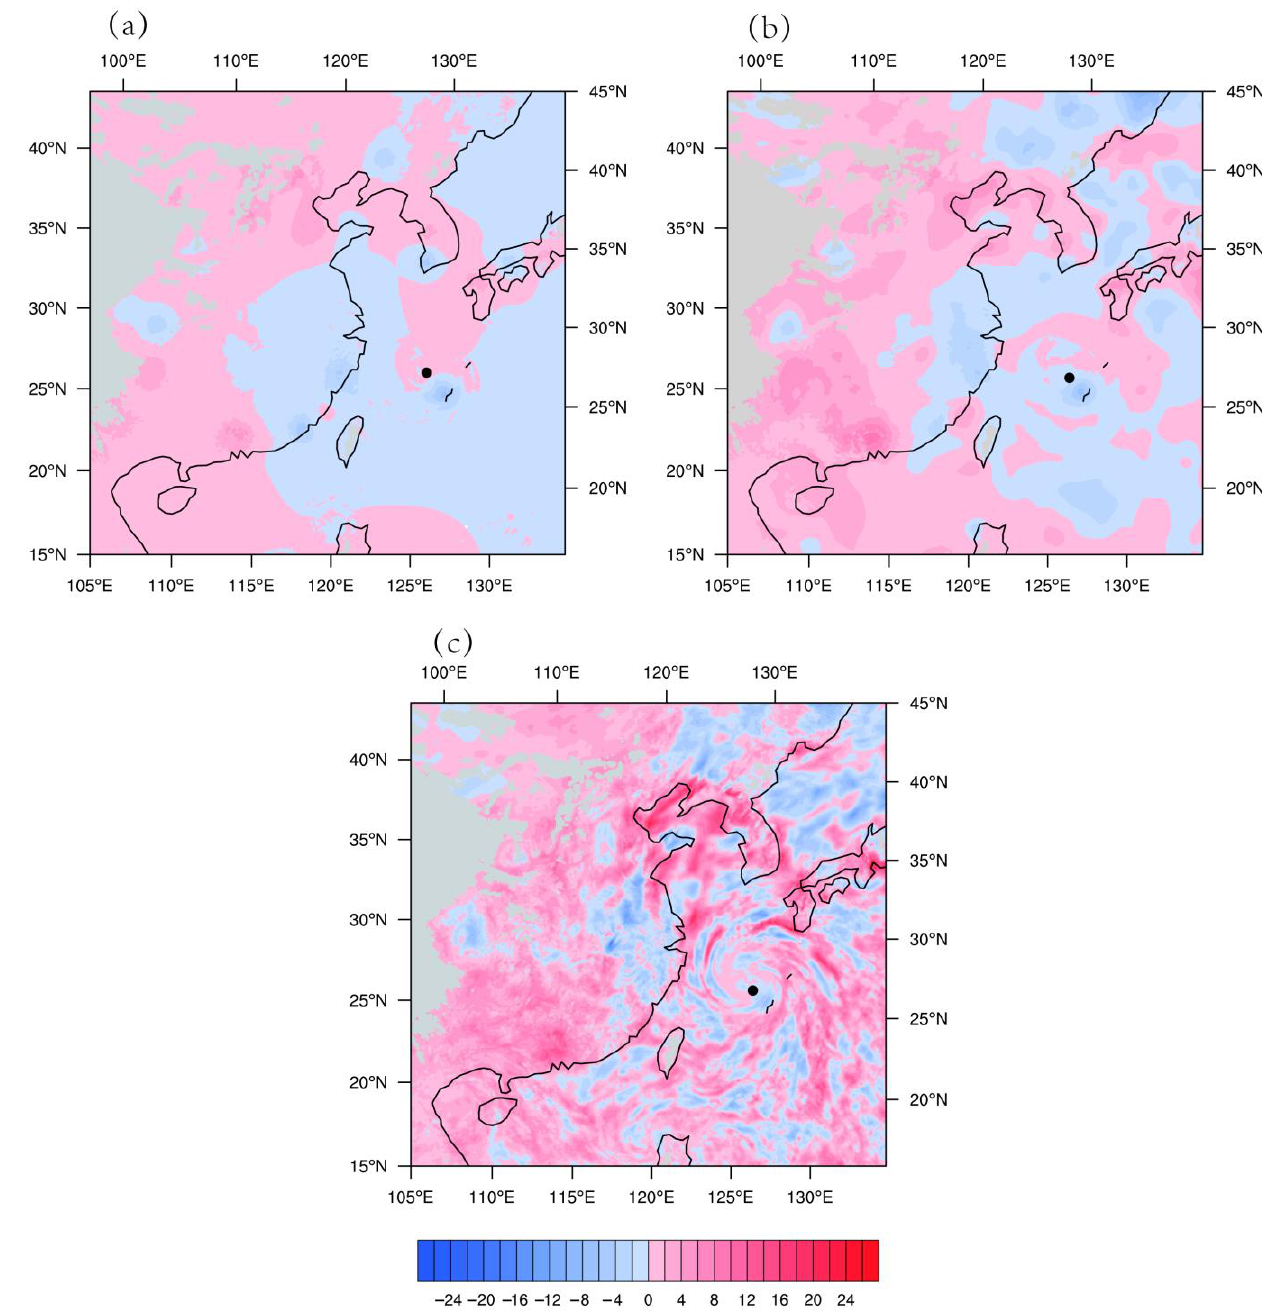
Figure 9. 850 hPa relative humidity increment (unit: %) of ( a ) the CONV experiment, ( b ) the 3DVar experiment, and ( c ) the EnVar experiment at 0600 UTC on 21 July 2018. The black dots represent the typhoon center at 0600UTC on 21 July 2018.